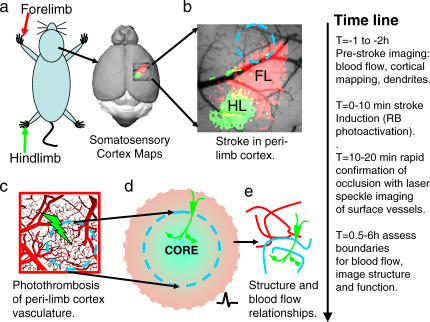
Experimental Setup for Examining the Relationships between Local Vascular Flow and Brain Structure and Function(A) Mice were stimulated by vibrating their fore- or hindpaws while IOS imaging was performed in the contralateral (opposite) cortex to produce somatosensory maps. Maps superimposed on a magnetic resonance imaging reconstruction of a C57 bl6 mouse brain from http://www.bnl.gov/CTN/mouse (at their approximate locations and sizes) [65].(B) Enlarged view of maps and possible stroke site expected to cause a deficit in the forelimb (FL) map, but to spare hindlimb (HL) function. The point at which map function returns for these ministrokes is termed the functional edge.(C) Boxed region with stylized images of vessels depicting photoactivation of RB by green light. (D) For large strokes up to 1 mm in diameter the ischemic core would contain little or no vascular flow (colored light blue to illustrate ischemia, the dark blue-dashed line is the no-flow boundary). The edges of the core are shown as a mixture of pink and blue to illustrate partial oxygenation due to diffusion from nearby flowing vessels. It is possible that some synaptic structure may be supported within the core by diffusion of blood-derived factors. Outside of the core we will assess where map function is present; note action potential icon.(E) Schematic showing how dendritic structure (green) is assessed relative to flowing (red) and nonflowing (blue) vessels.